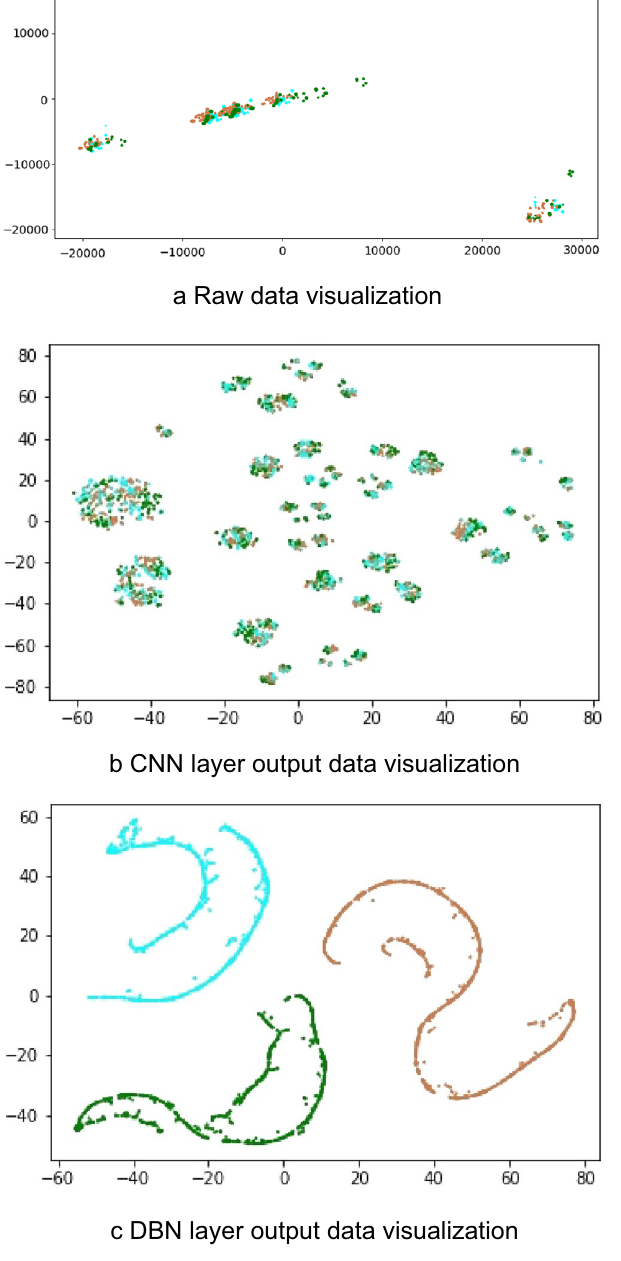
Figure 5. T-SNE dimensionality reduction